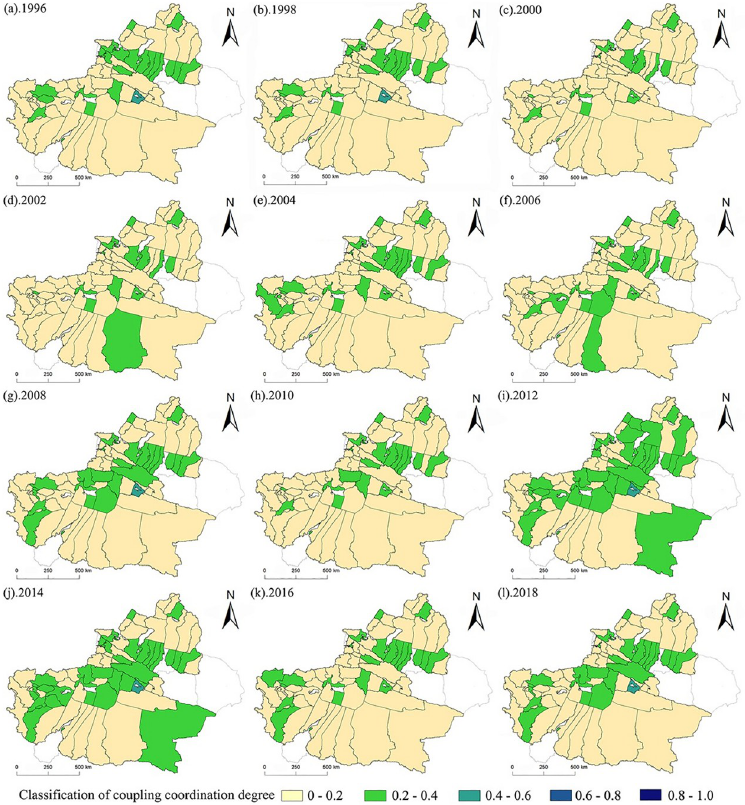
Fig 6. Coupling and coordinated temporal and spatial distribution of PECL in XJC from 1996 to